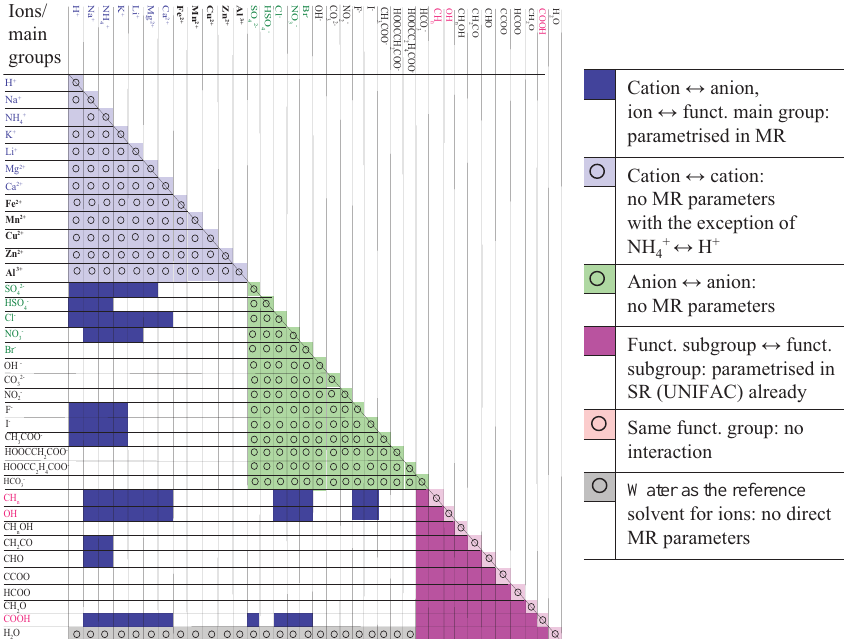
Figure 4. Scheme of the currently used interactions in the MR and SR parts. Parameters for ion ↔ ion and ion ↔ organic main group interactions are all incorporated in the MR part and set to zero in the SR (UNIFAC) part.